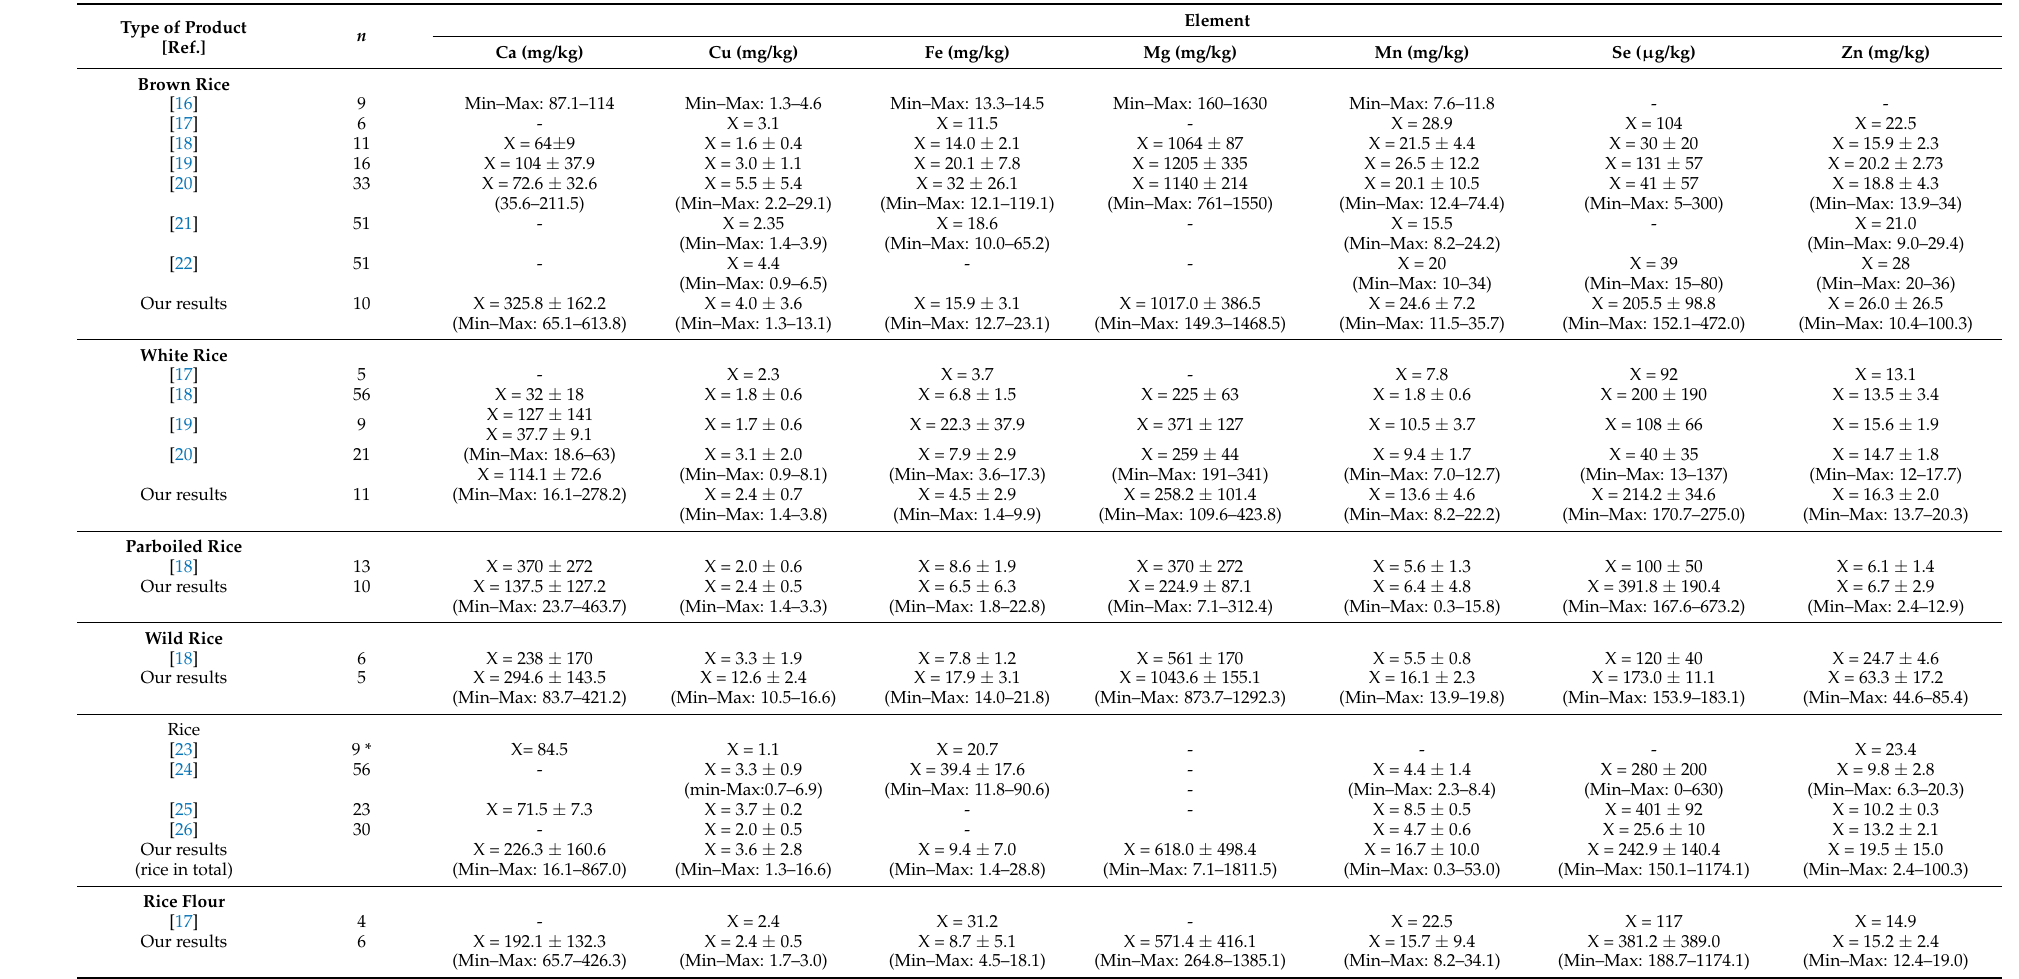
Table 6. Content of elements in rice and rice products determined by other